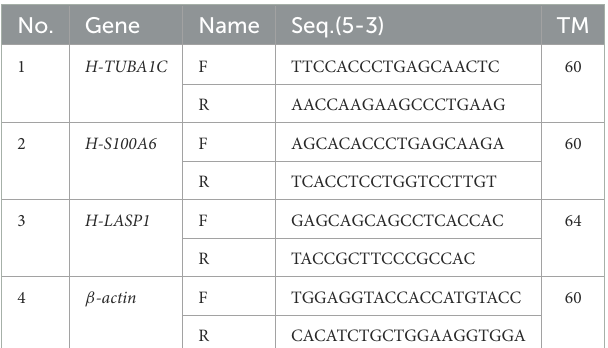
TABLE 1 Primers designed for